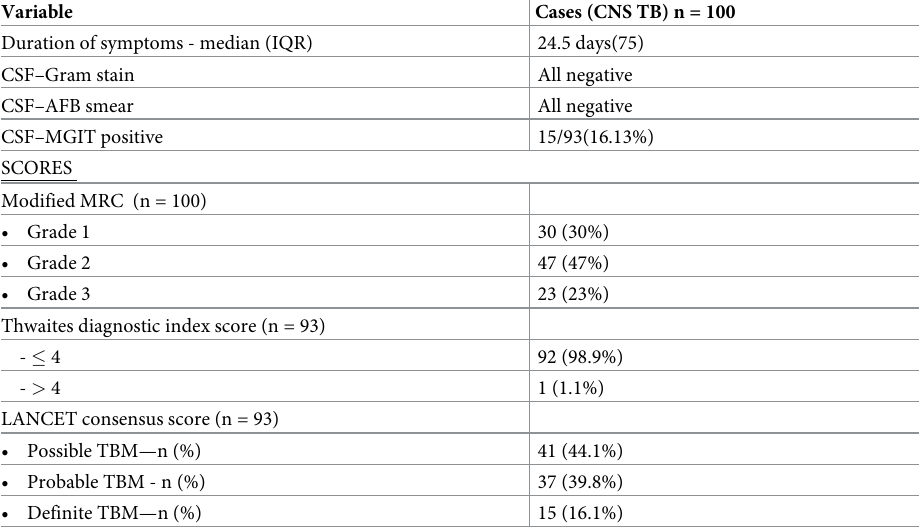
Table 1. Characteristics of cases (CNS